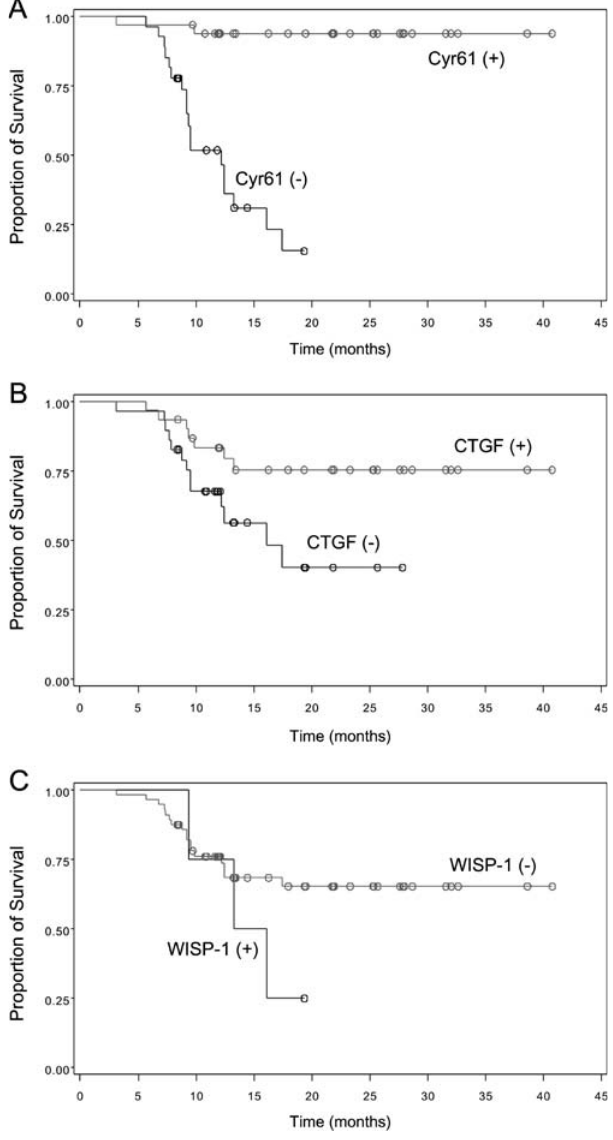
Figure 4. Survival curves from the time of diagnosis for NSCLC patients with either high ( + ) or low ( 2 ) expression of Cyr61(A), CTGF (B), and WISP-1(C).